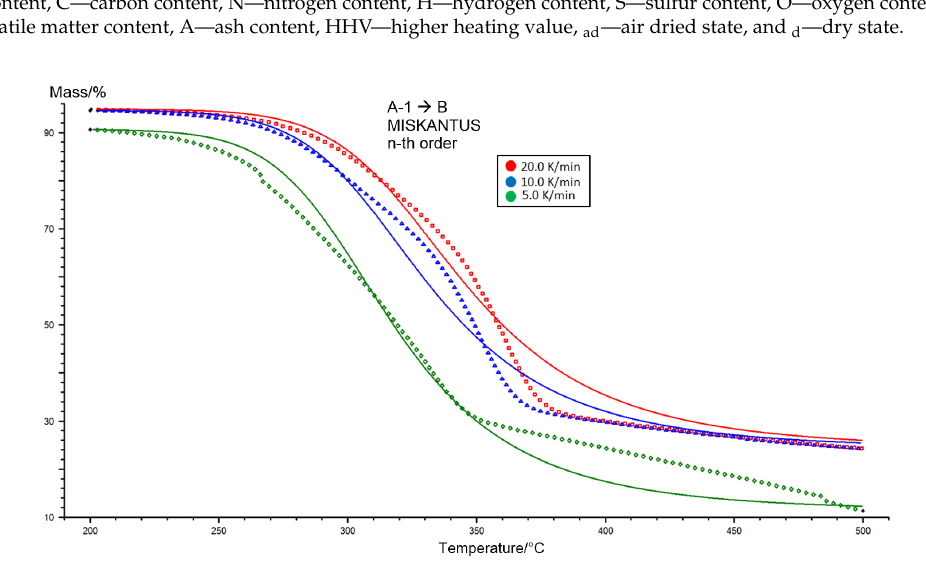
Figure 8. Fitting the calculated kinetic model to the experimental data for the Miscanthus. One important fact that has to be remembered is that the estimated kinetic trio is only the optimal mathematical fit of the equation to the experimental data, and in this case there is no exact physical significance (reaction order). By using the above fitting proce- dure, the activation energy, thus delivered, is visible: It is only used to correlate the model with the experimental data and does not matter with reference to the definition. The con- clusions are that kinetic analysis methods employing the results of different heating ratios were more suitable than a single heating ratio method. 3. Discussion 3.1. TGA Analysis A TGA analysis of Miscanthus was performed in an inert atmosphere N 2 using TGA Netzsch Tarsus 209 FC (Netzsch, SelbBavaria, Germany). In Figure 9 we see the derivative thermogravimetric Differential Thermogravimetric DTG and thermogravimetric TG anal- ysis results of the Miscanthus sample torrefied in an N 2 atmosphere. Figure 9. Thermogravimetric analysis of the Miscanthus torrefaction process for the production of biocarbon at a temperature of 525 °C (heating ratio 20 K/min) in an N 2 atmosphere.